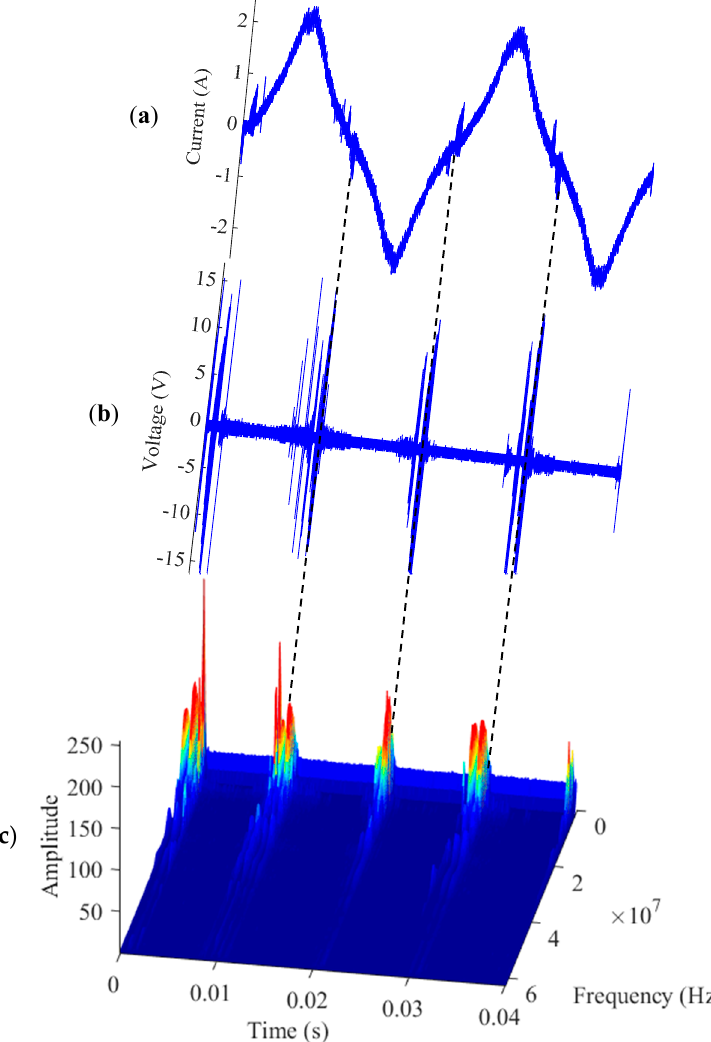
Figure 7. Signals’ STFT for the electrical drill. ( a ) line current; ( b ) high-frequency signals; ( c ) signals’ STFT of arc faults.